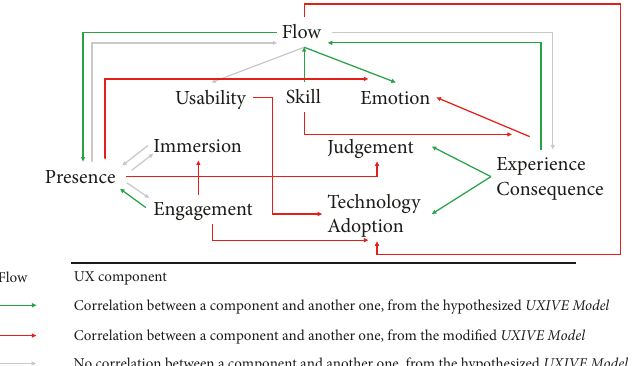
Figure 4: The modified UXIVE